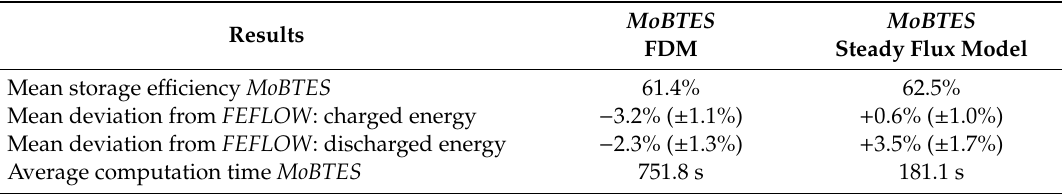
Table 2. Mean values of the MoBTES simulation results for both local model variants and deviation to FEFLOW benchmark models (standard deviation in brackets).